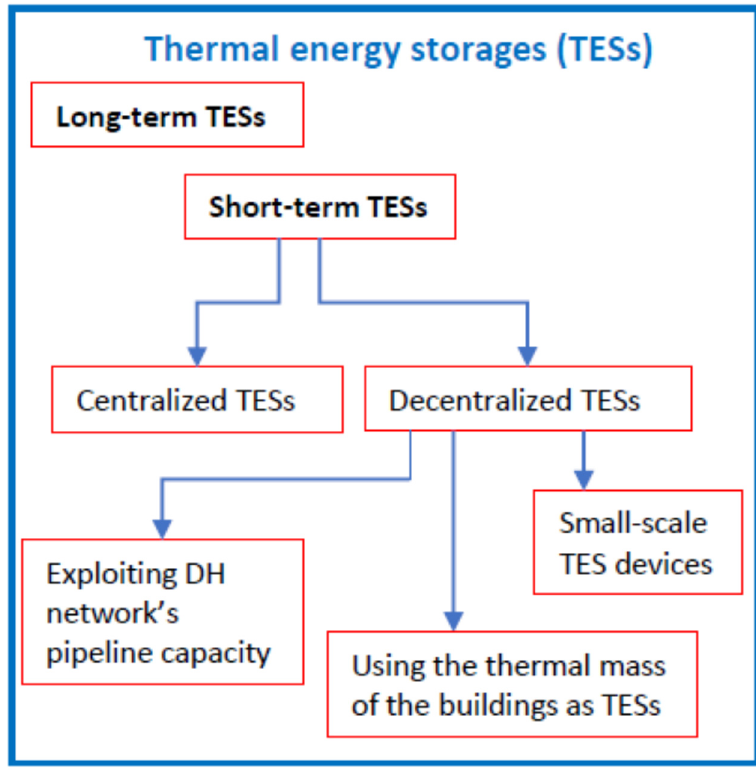
Figure 6. The proposed classification of long-term and short-term TESs.